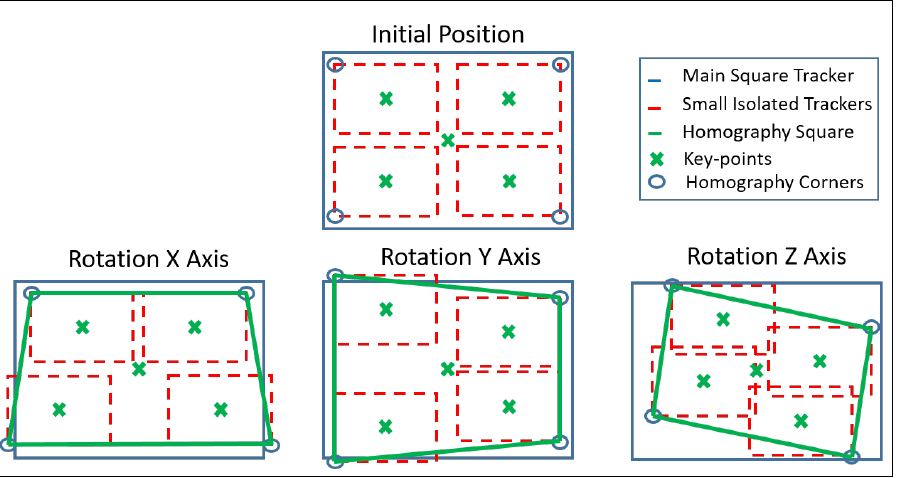
Figure 8. Rotation solution for the